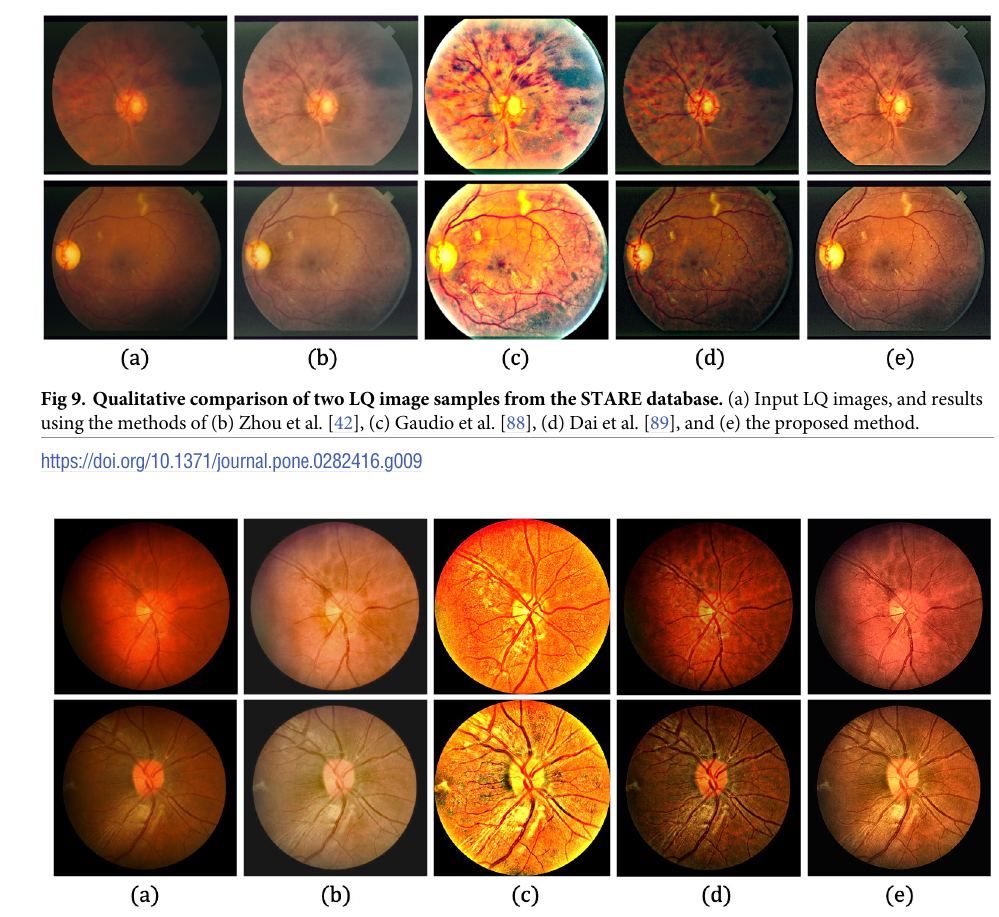
Fig 10. Qualitative comparison of two LQ image samples from the CHASE_DB1 database. (a) Input LQ images, and results using the methods of (b) Zhou et al. [42], (c) Gaudio et al. [88], (d) Dai et al. [89], and (e) the proposed